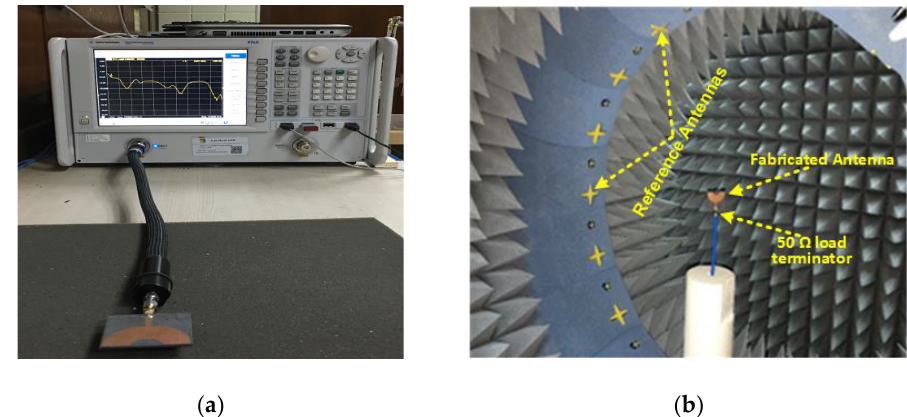
Figure 6. Measurement setup: ( a ) PNA measurement scenario; ( b ) StarLab measurement scenario.